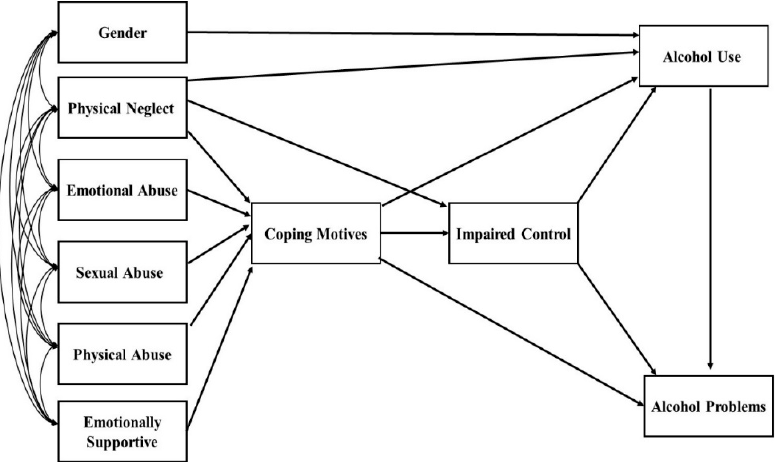
Figure 1. Conceptual model that allowed all the exogenous variables to correlate with each other. This model shows each path we tested for significance.